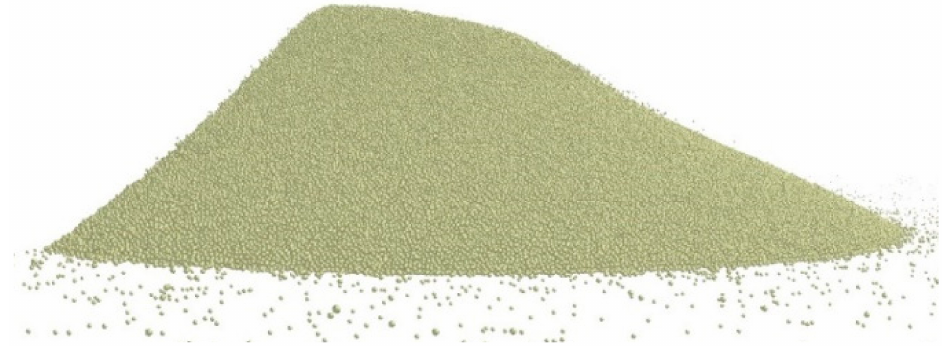
Figure 2. Flow chart of prediction method of bucket fill factor.